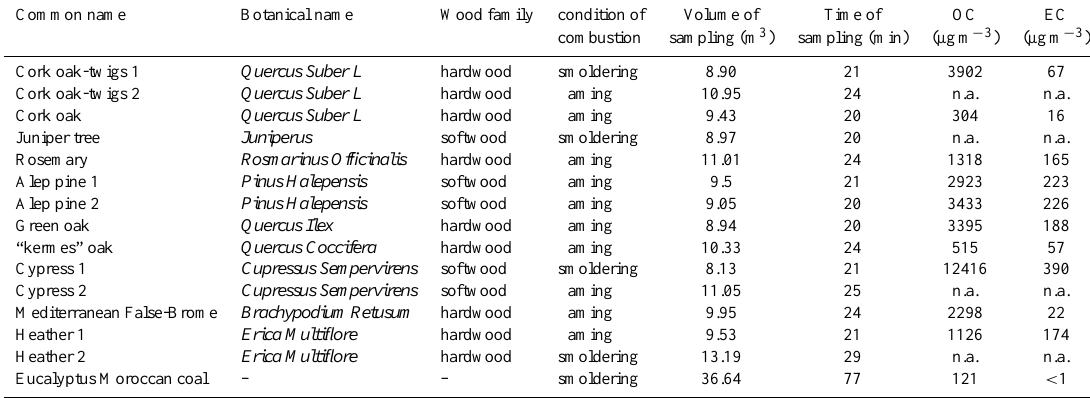
Table 1. Description of wood species studied in this